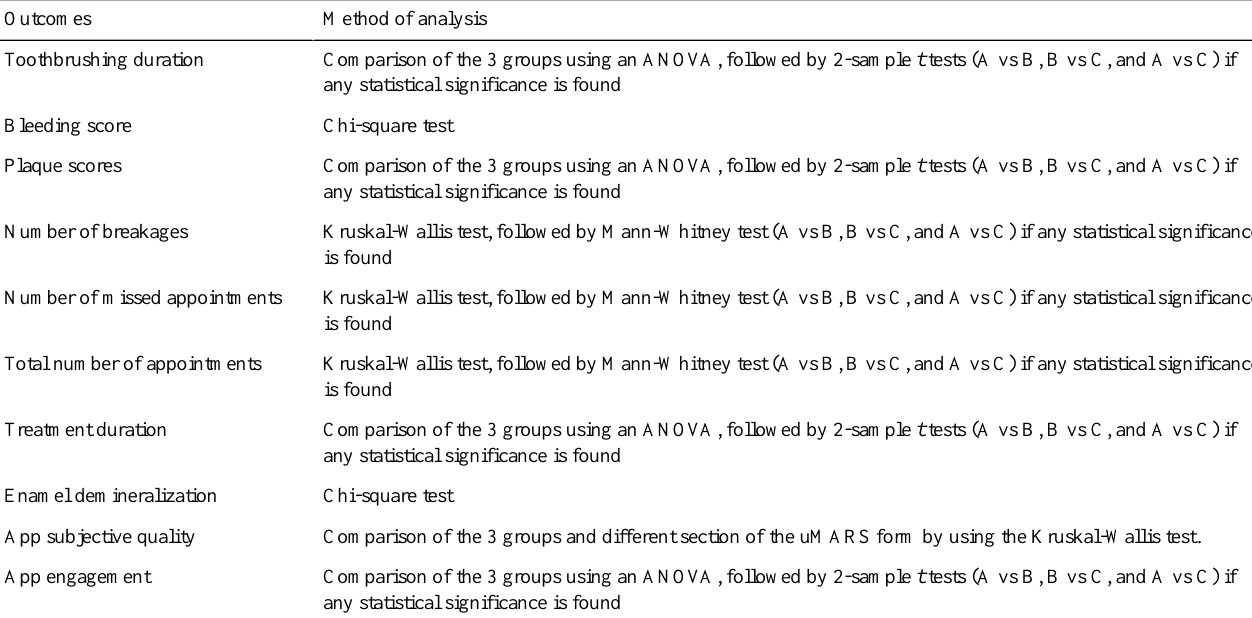
Table 2. A summary of proposed statistics for outcome analysis. Method of